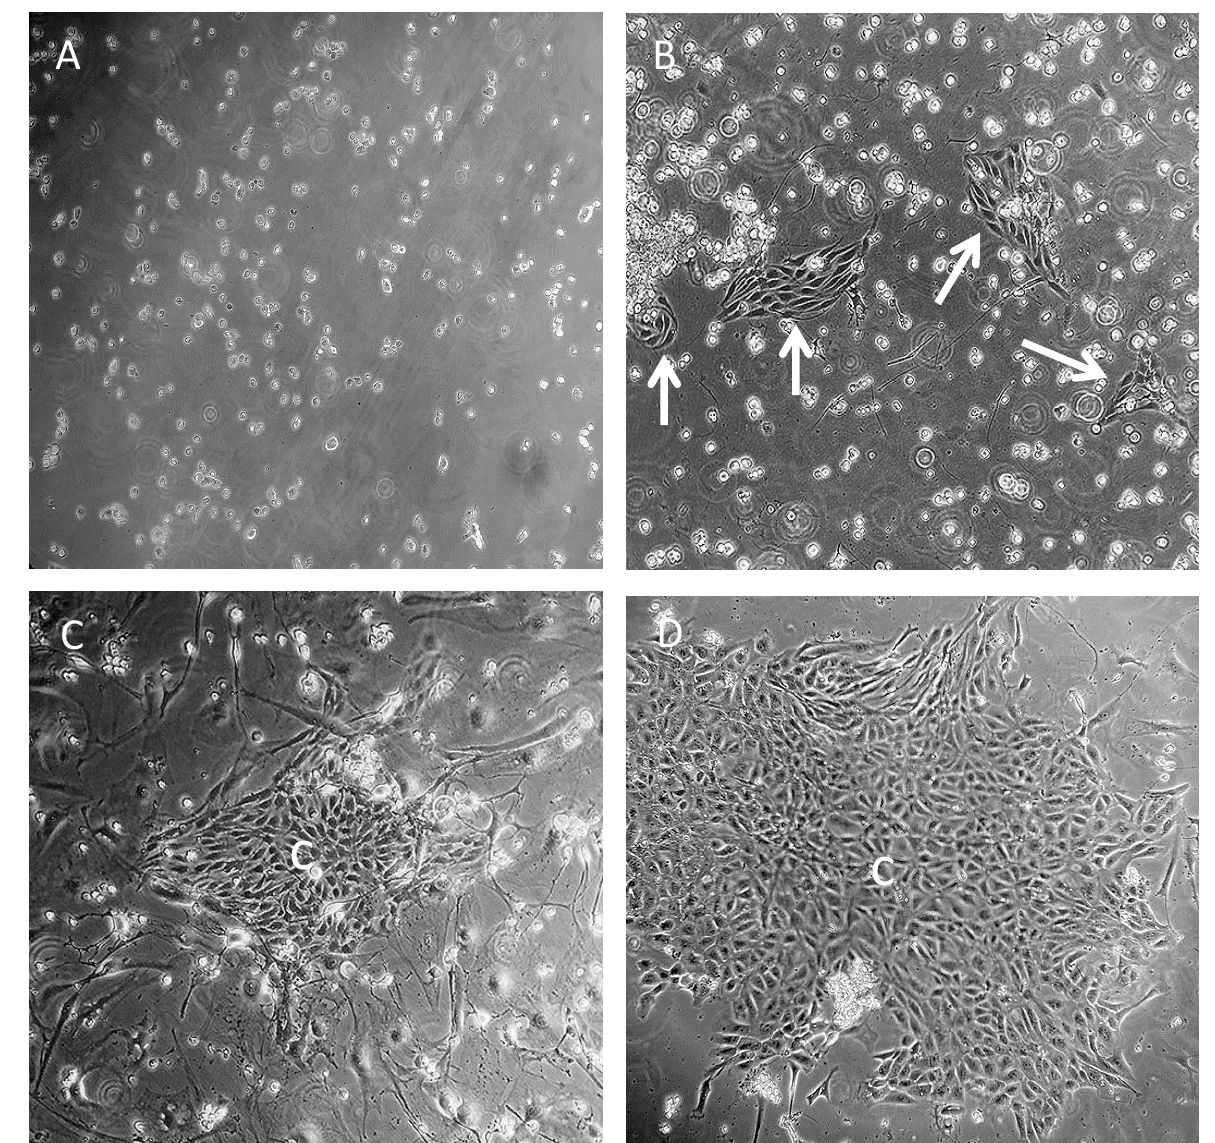
Figure 1. Freshly isolated single SCs ( A ) or SC clusters ( B – D ) were seeded on collagen-coated T25 flasks with ( C ) or without irradiated feeder cells ( A , B , D ). After 24 h ( A , B ) or 72 h ( D ) complete CM was added. Single SCs showed less numbers and patches ( A ) compared to SC clusters with larger patches of SCs after 24 h ( B , arrows). After 72 h, SC clusters with complete CM only ( D ) formed larger colonies (c) compared to SC clusters seeded onto irradiated feeder cells ( C ) (magnification ×